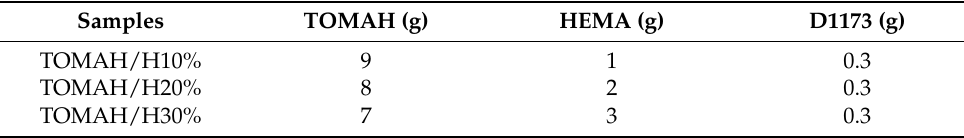
Table 1. Compositions of TOMAH/H